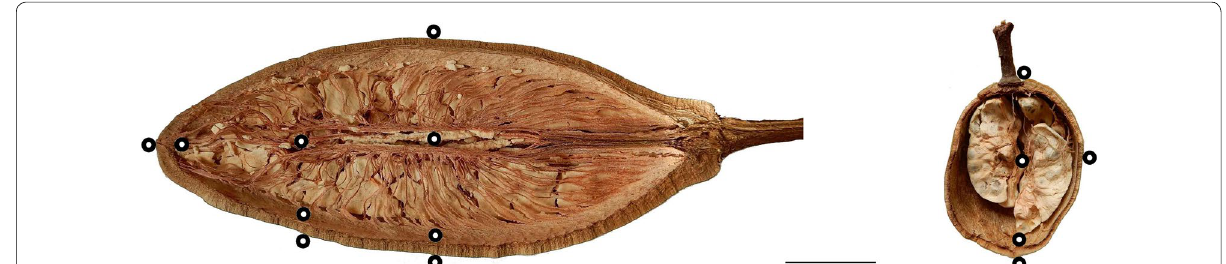
Fig. 1 Bisected fruits and position of nine thermocouples in A. digitata and five thermocouples in A. gregorii. Scale bar 50